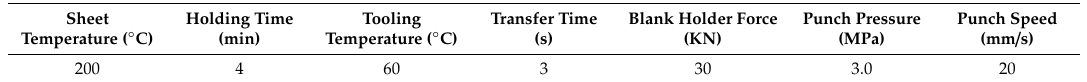
Table 5. The simulation process parameters.